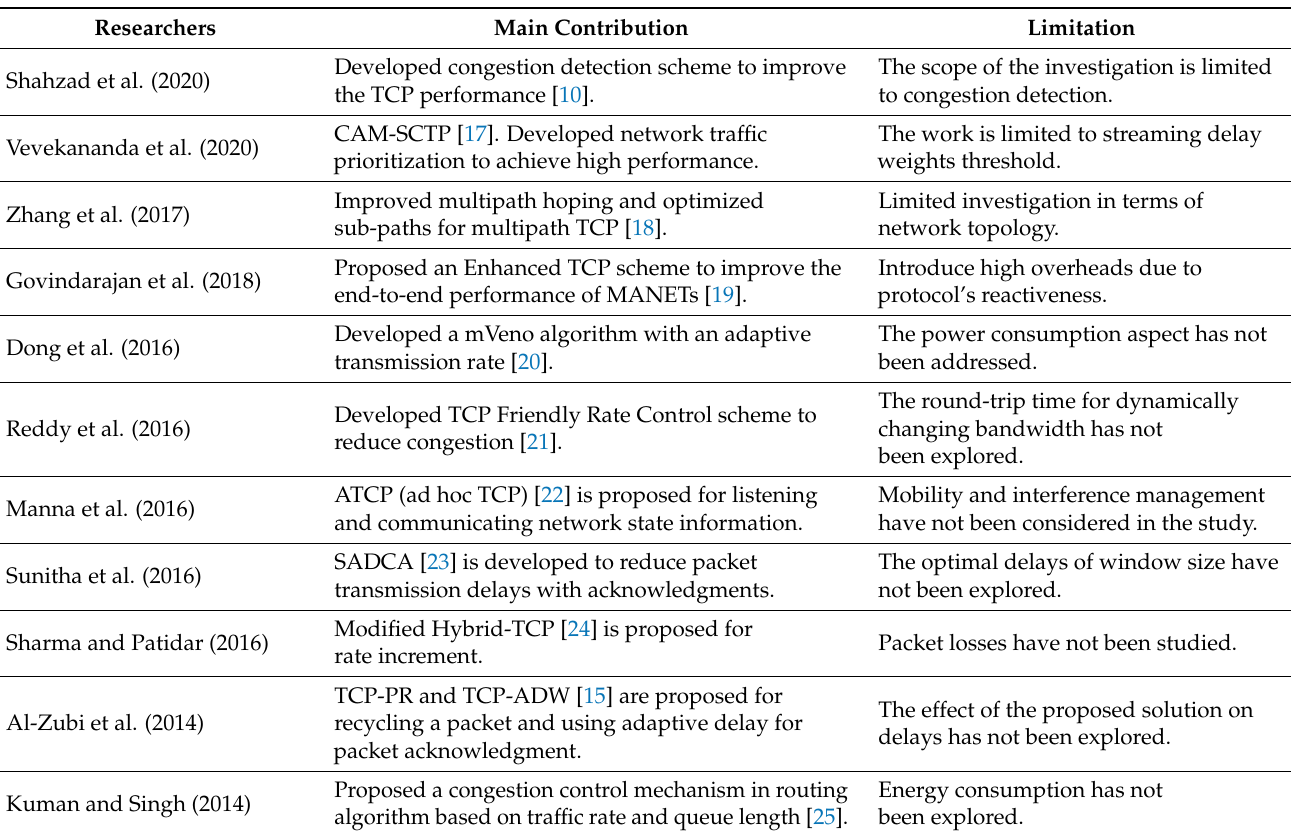
Table 1. Summary of related